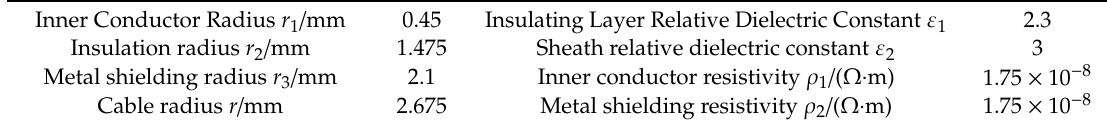
Table 2. Parameters of RG223 coaxial cables.